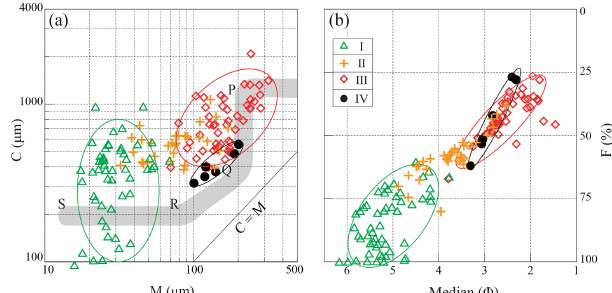
Figure 6. C – M and F – M diagrams of fluvial sediments from the upper Min River.